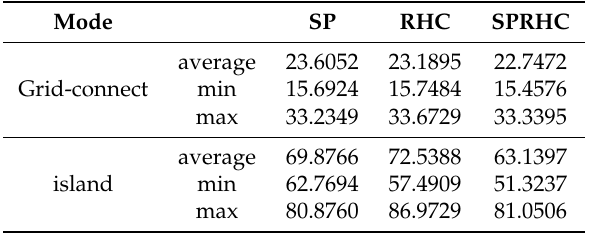
Statistic of microgrid (MG) total operating cost with stochastic programming (SP), recording horizon control (RHC) and combined stochastic programming and recording horizon control (SPRHC)